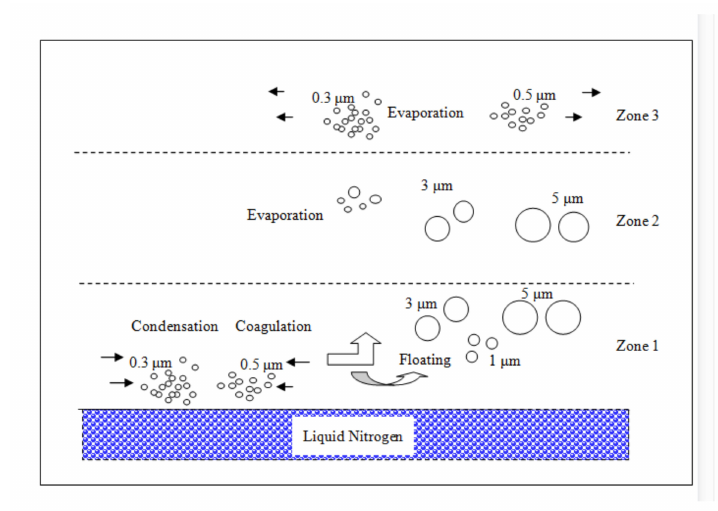
Figure 6. Model of transition of aerosol particles in the vicinity of the LN 2